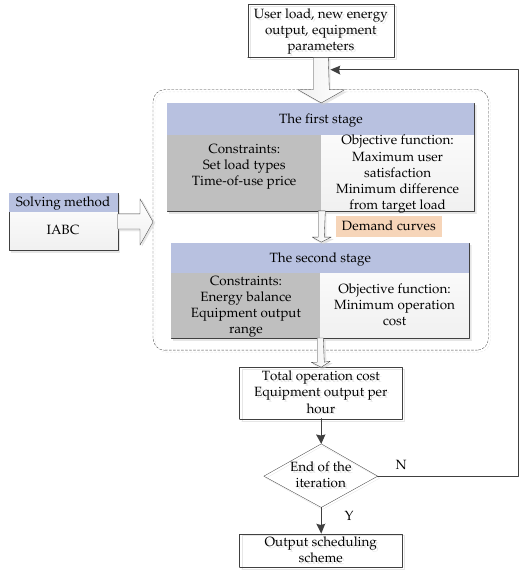
Figure 2. Two-stage scheduling scheme.